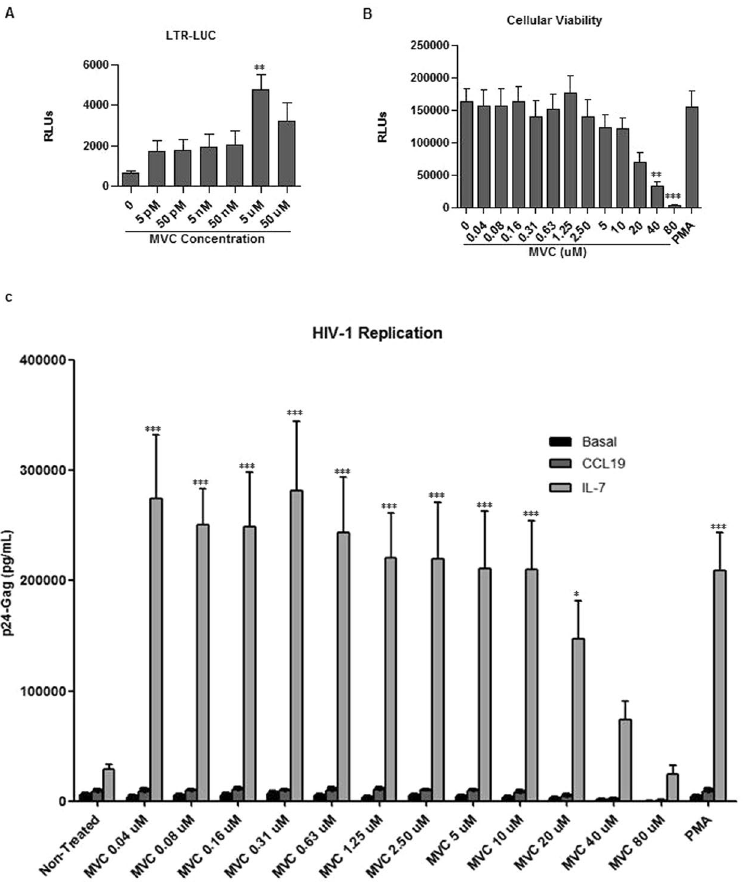
Figure 2. LTR activation and HIV-1 replication in MVC-treated CD4 + T cells. ( A ) Analysis of luciferase expression (RLUs) in CD4 + T cells electroporated with pLTR-LUC vector. MVC was added 4 hr post- transfection and cells were incubated for subsequent 18 hr. ( B ) Cellular viability was measured by chemiluminescence (RLUs) in CD4 + T cells treated with MVC or PMA/PHA for 18 hr. ( C ) Primary CD4 + T cells were treated with CCL19 or IL-7 for 5 days, then infected with X4-tropic NL4–3 strain and cultured for 5 additional days. MVC at indicated concentrations or PMA/PHA were added during the last 18 hr. HIV-1 replication was assessed by quantifying p24/Gag levels in the culture supernatant. Statistical significance was calculated using Kruskal-Wallis test with Dunn’s Multiple Comparison Test ( * p < 0.05 and *** p < 0.001) for ( A ) and ( B ) or using two way ANOVA with Bonferroni post-test analysis ( ** p < 0.01 and *** p < 0.001) for ( C ). All data are represented as mean ±